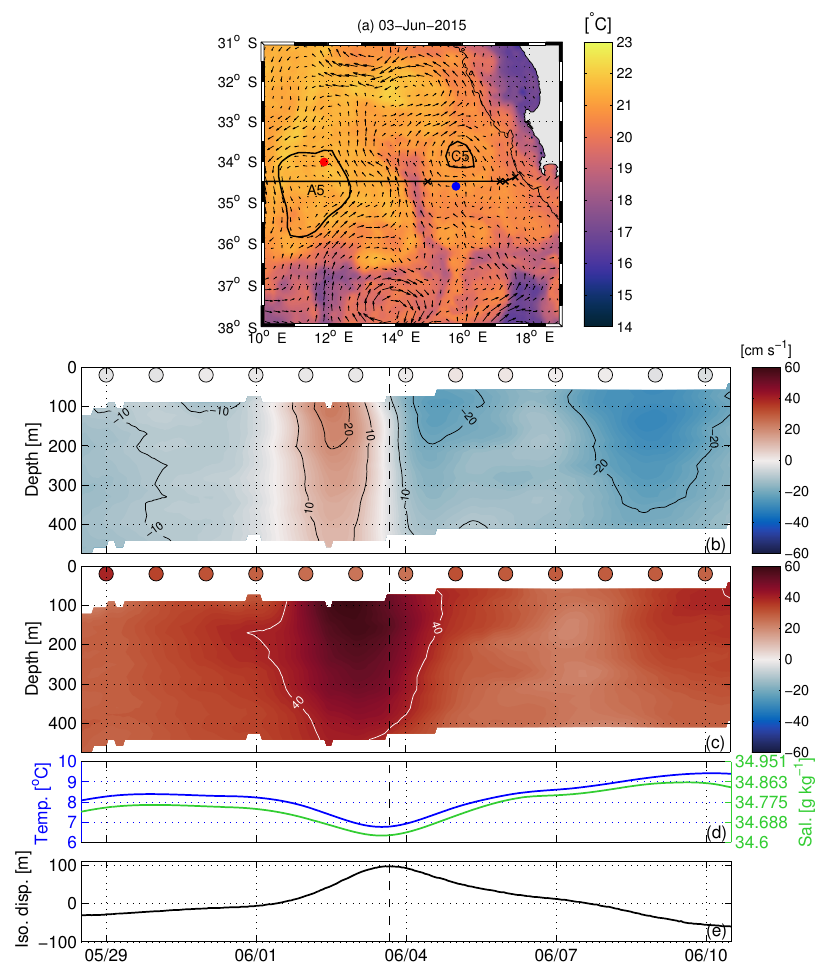
Figure 9. Cyclonic eddy: (a) SST satellite image for selected date (vertical black line on the time series). Vertical–temporal section of the u component (b) and v component (c) of the current speed measured from the upward-looking ADCP at M4. The colored circles at the top of the section show the u and v component of the current speed from altimetry data. (d) Temporal evolution of temperature (blue line) and salinity (green line) and (e) the isopycnal displacement recorded at the first SBE37 MicroCATs between 470 and 500m depth.